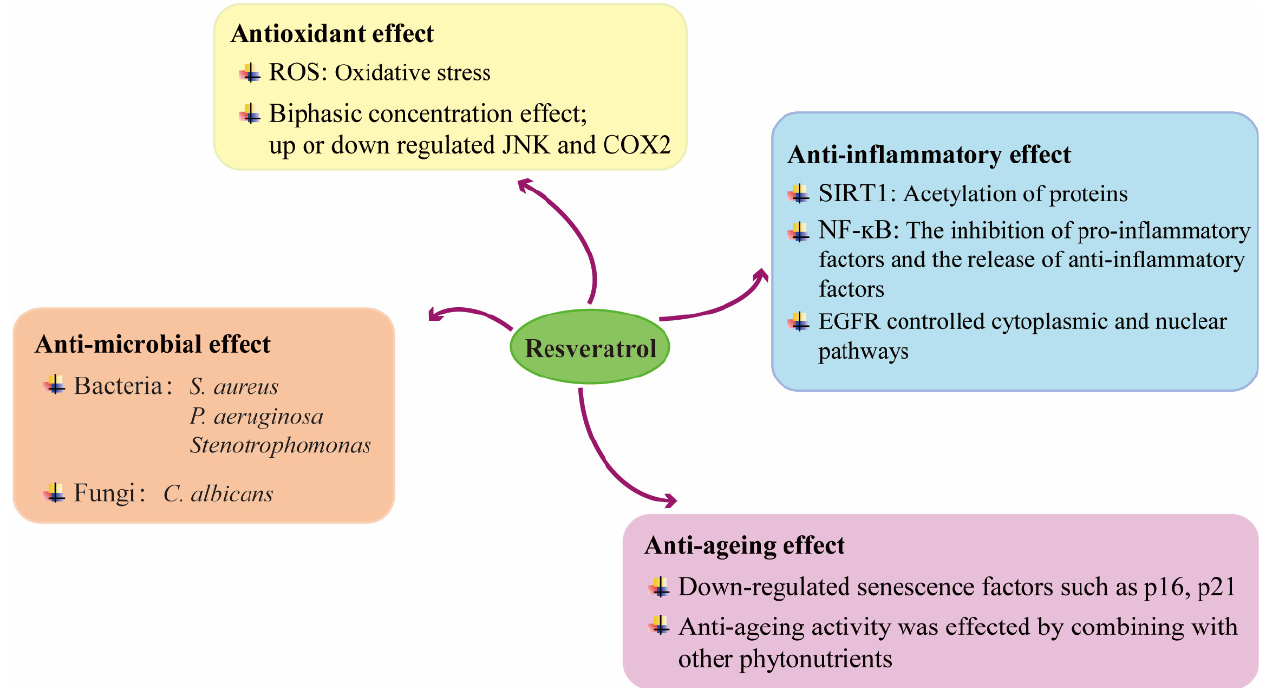
Figure 3. Mechanisms underlying the beneficial effects of RSV on wound healing.